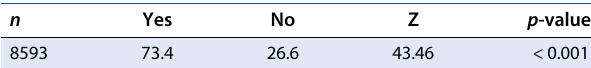
Table 7: Overall